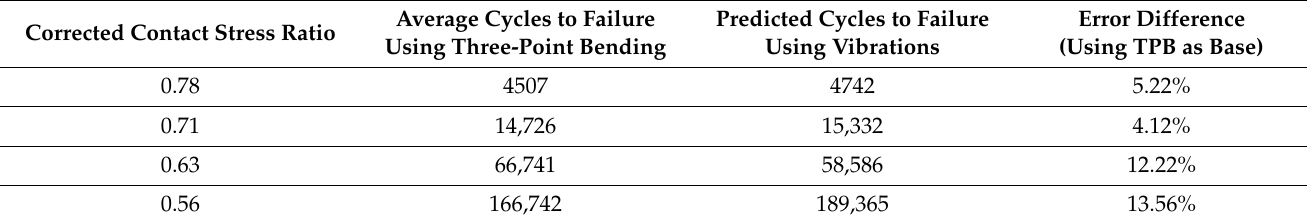
Table 3. Experimental results from Three-Point Bending and Vibration tests, considering the contact stress.